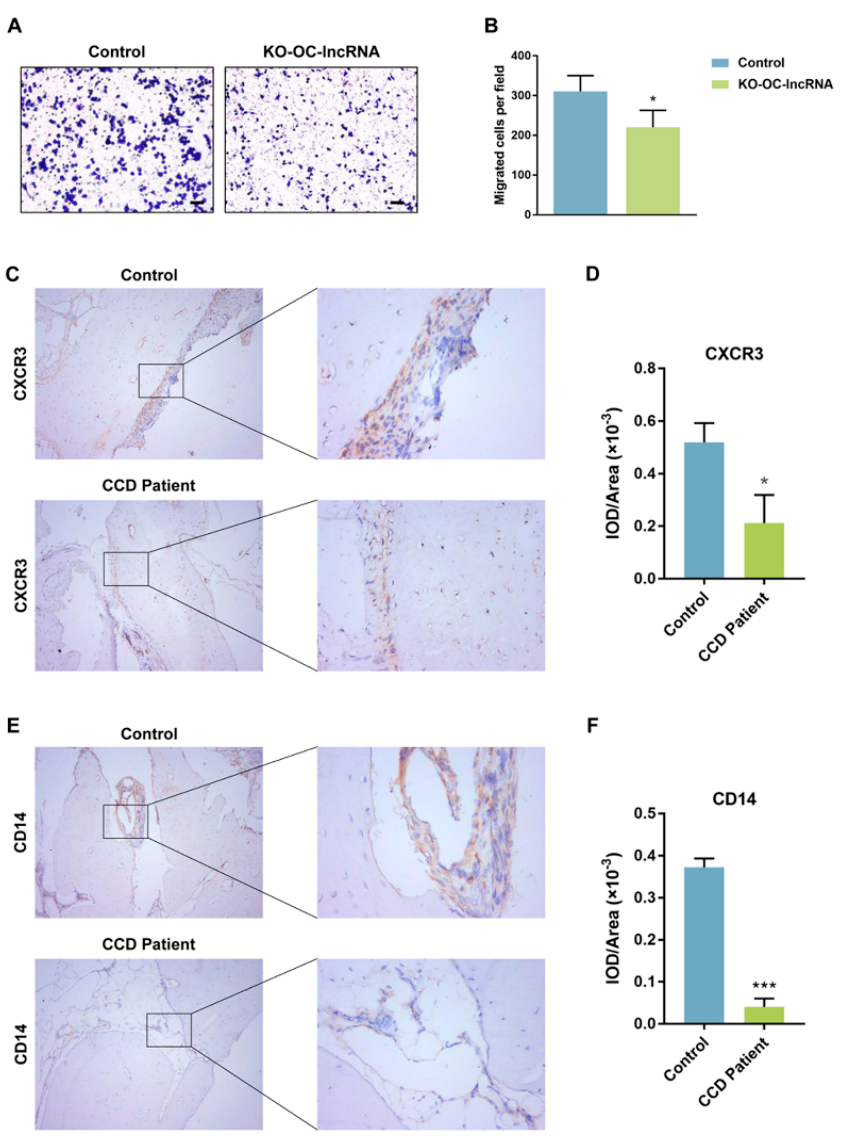
Figure 6. Monocytes chemotaxis detected by and immunohistochemistry. ( A ) Representative images of transwell migration assay. Scale bar, 500 µ m. ( B ) Quantitative analysis of transwell migration. ( C ) Immunohistochemistry for CXCR3 in alveolar bone (Left panel, × 100; Right panel, × 400). ( D ) Quantification of CXCR3 protein expression. ( E ) Immunohistochemistry for CD14 in alveolar bone (Left panel, × 100; Right panel, × 400). ( F ) Quantification of CD14 protein expression. Error bars represent SD. * p < 0.05, *** p < 0.001.